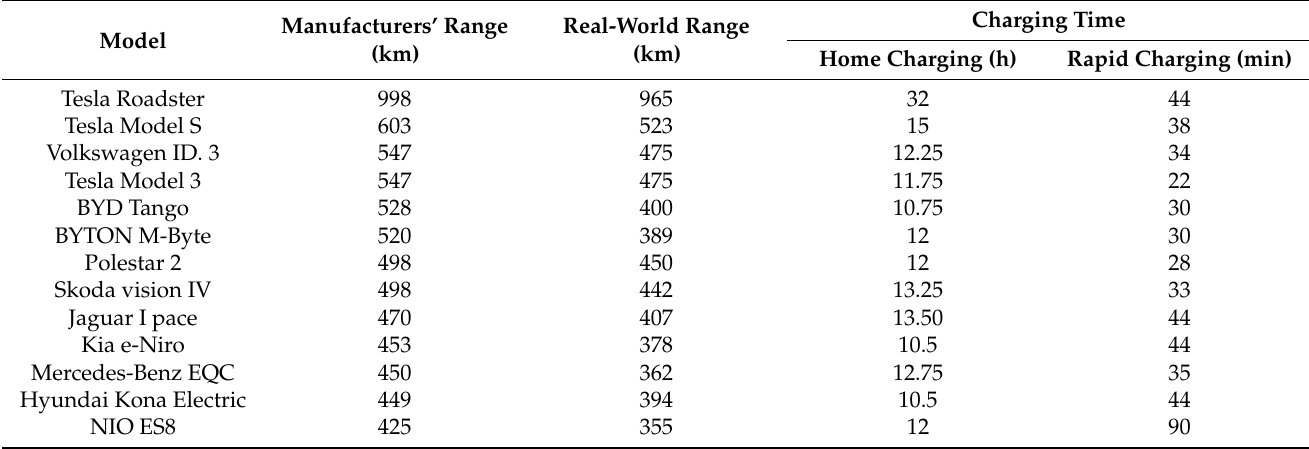
Table 2. The most modern EVs available in the market: predicted and real-world range, home and rapid charging times [47,52–54].